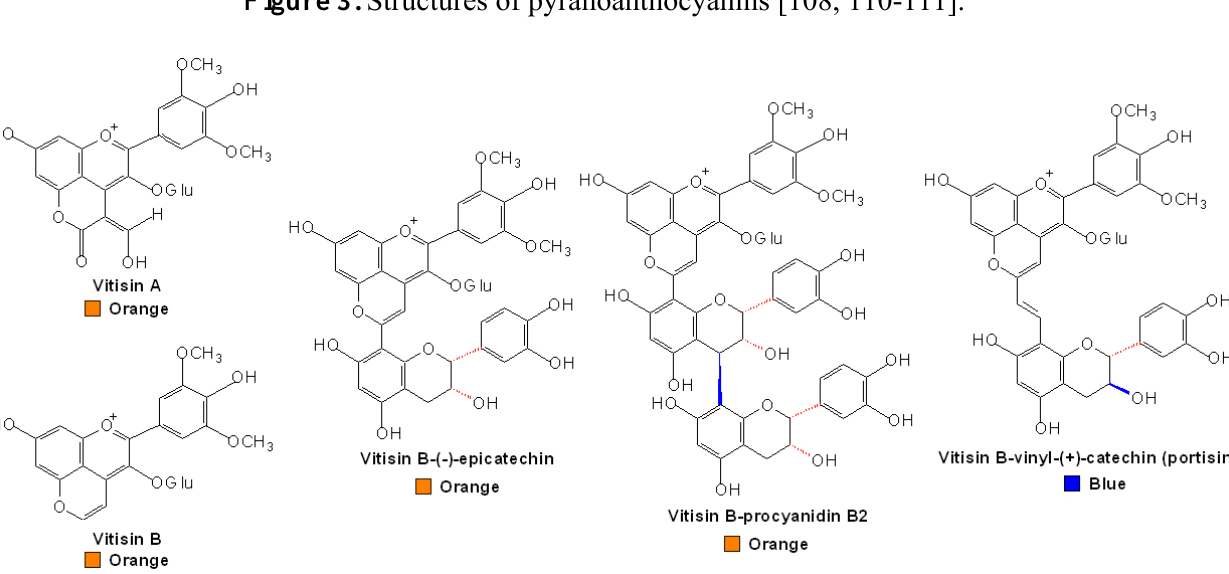
Figure 3. Structures of pyranoanthocyanins [108,